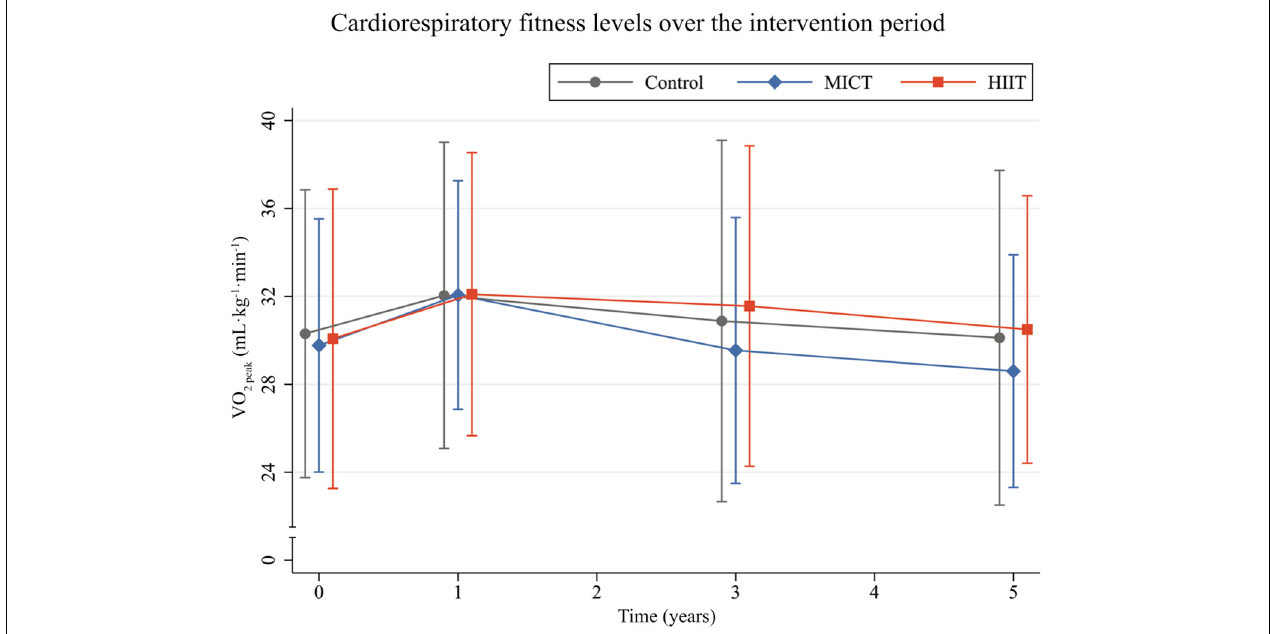
FIGURE 2 | Cardiorespiratory fitness levels, measured as peak oxygen uptake (VO 2 peak ), in the Control (gray), high-intensity interval training (HIIT, orange), and moderate-intensity continuous training (MICT, blue) group over time. Whiskers represent one standard deviation below and above the group mean.